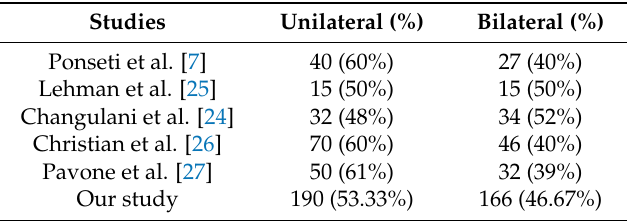
Table 6. Comparison of laterality with other studies.